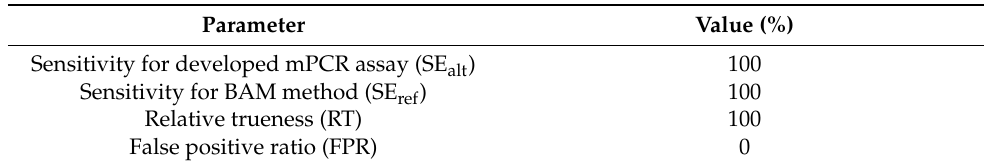
Table 6. Results of each parameter in unpaired sensitivity study of the developed mPCR assay and BAM method for detection of each target bacterium. Parameter Value (%) Sensitivity for developed mPCR assay (SE alt )